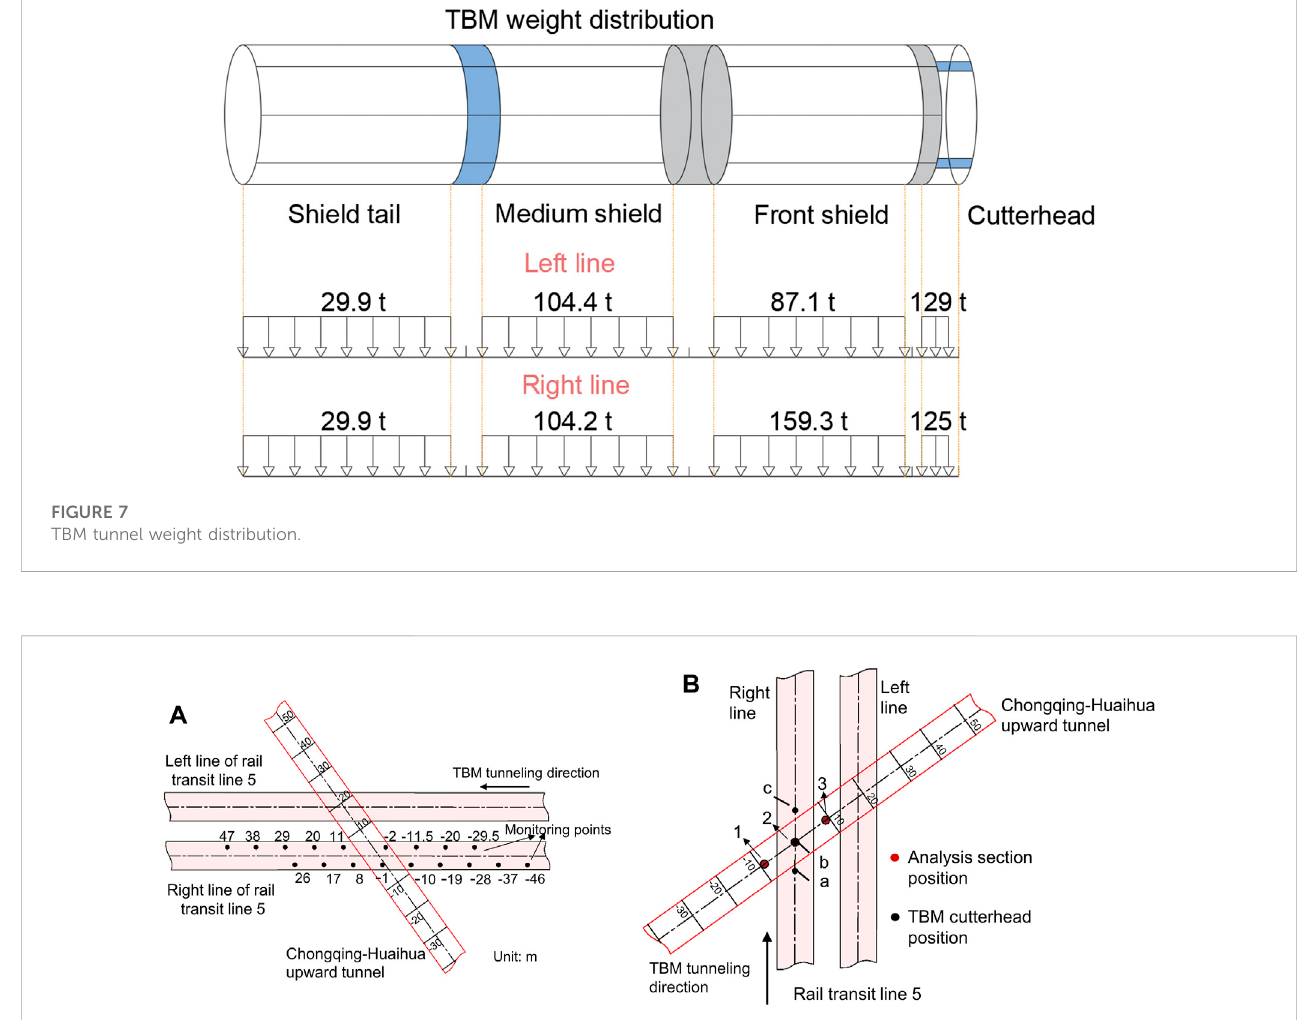
FIGURE 8 Layout of monitoring points of the operational tunnel. (A) Displacement monitoring. (B) Internal force monitoring.